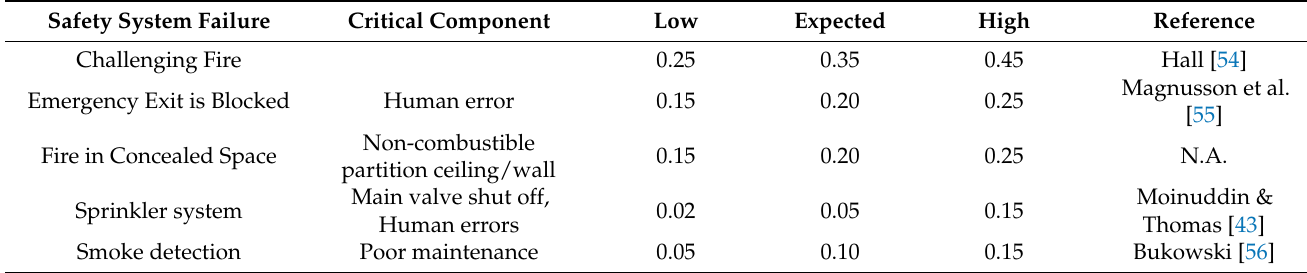
Table A4. Failure probabilities of technical risks implemented in Event Tree